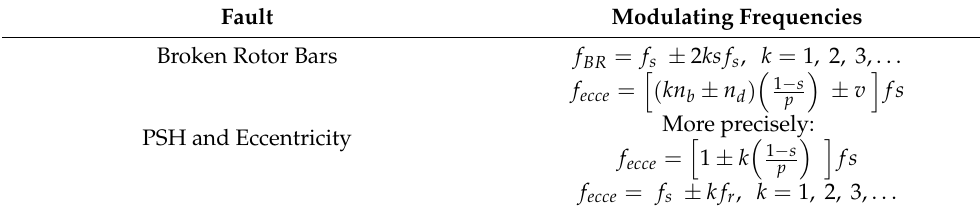
Table 1. Fault definition